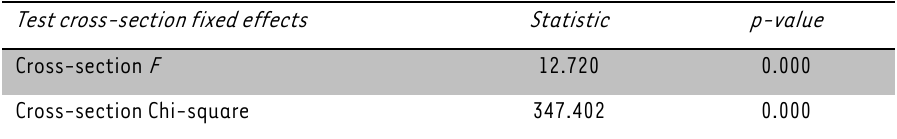
TABLE 5: Fixed effects redundancy test Test cross-section fixed